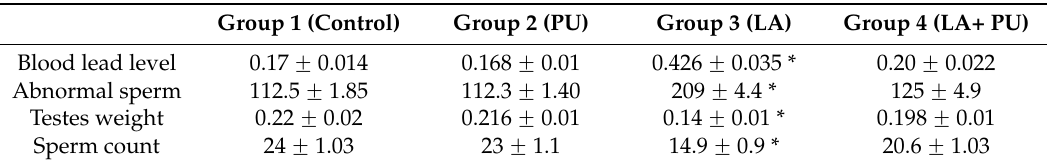
Table 2. LA effect on testes weight grams (g), sperm abnormality (per 1000 sperm), blood lead level ( µ g/mL), sperm count ( ˆ 10 6 ). All results shown as mean ˘ standard error (SE).